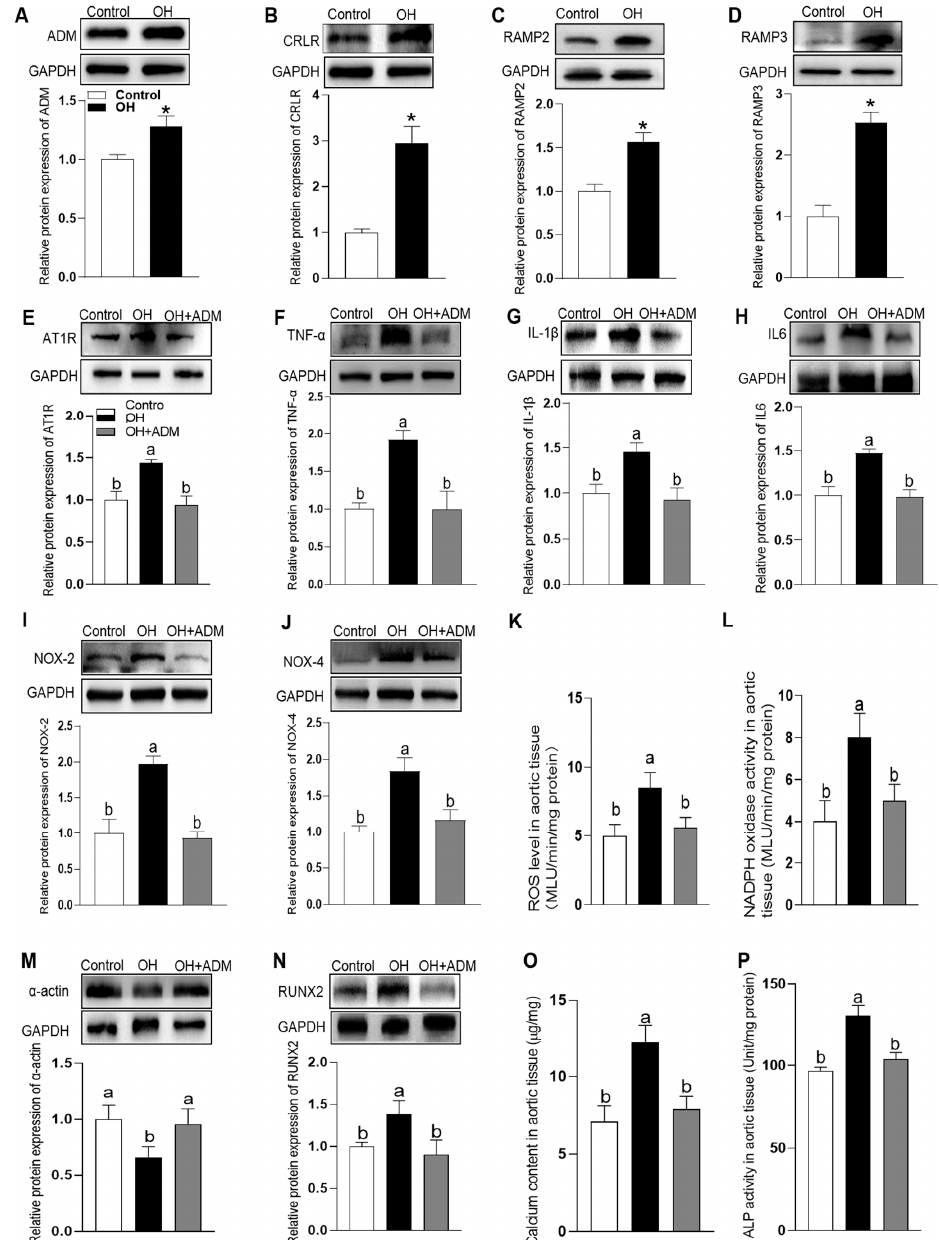
Figure 2. The endogenous protein expression levels of ADM, calcitonin receptor-like receptor (CRLR), receptor activity-modifying protein 2 (RAMP2) and RAMP3 ( A – D ) and the effects of ADM on AT1R expression ( E ), inflammation ( F – H ), oxidative stress ( I – L ) and calcification ( M – P ) in the tunica media of aorta after 32 weeks of high-fat diet (HFD) feeding. The protein expression levels of proinflam- matory cytokines TNF- α ( F ), IL-1 β (G) and IL6 ( H ) were measured to reflect inflammation; the two important catalytic subunits of NADPH NOX2 and NOX4 protein expression levels ( I , J ), ROS level ( K ) and NADPH oxidase activity ( L ) were detected to reflect oxidative stress; and the smooth-muscle lineage marker α -actin and runt-related transcription factor 2 (RUNX2, a DNA-binding transcription factor that regulates target genes in bone formation) protein expression levels ( M , N ), calcium content ( O ) and ALP activity ( P ) were determined to reflect calcification. NADPH, nicotinamide adenine dinucleotide phosphate. GAPDH was used as an internal control for Western blotting analysis. n = 4–8 rats. The values are presented as the mean ± SEM. * p < 0.05 vs. control group (two-tailed unpaired t -test, ( A – D )). Values with the same superscript letter are not significantly different and the different letters indicate significant differences between the groups ( p < 0.05, one-way ANOVA followed by Bonferroni post hoc analysis, ( E – P